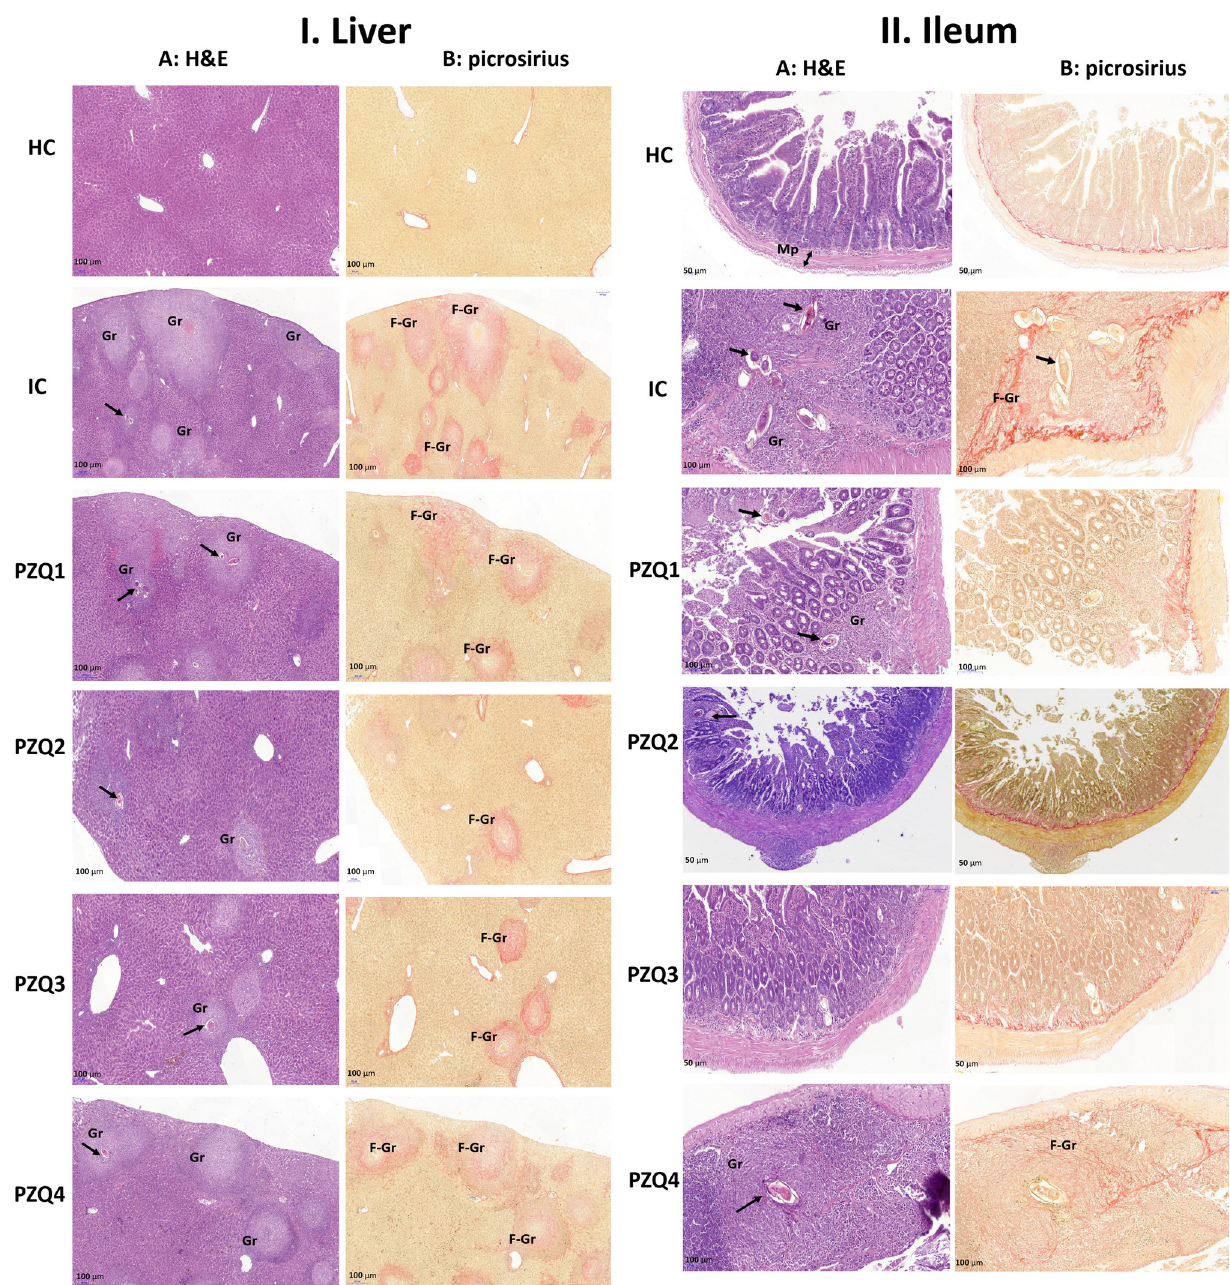
Fig 8. Effect of praziquantel treatment on the liver (I) and the ileum (II) histology of Schistosoma mansoni -infected mice stained with hematoxylin and eosin (A) and picrosirius (B). HC: Uninfected mice, IC: Infected-untreated mice, PZQ1: Infected mice treated with praziquantel at 100 mg/kg for 5 consecutive days, PZQ2: Infected mice treated with praziquantel at 100 mg/kg for 28 consecutive days, PZQ3: Infected mice treated with praziquantel at 18 mg/kg for 28 consecutive days, PZQ4: Infected mice treated with a single dose of praziquantel at 500 mg/kg. Simple arrows indicate Schistosoma mansoni egg; F-Gr: fibrotic granuloma; Gr: granuloma; bidirectional arrow indicates the height of the muscularis propria (Mp). effect. Accordingly, the ileal granuloma volume (Fig 9D) was most markedly reduced after the PZQ3 regimen (89.59% reduction, p < 0.001). PZQ1 and PZQ2 regimens reduced ileal granu- loma volumes by 75.59 and 81.59% (p < 0.05), respectively, while no significant difference was